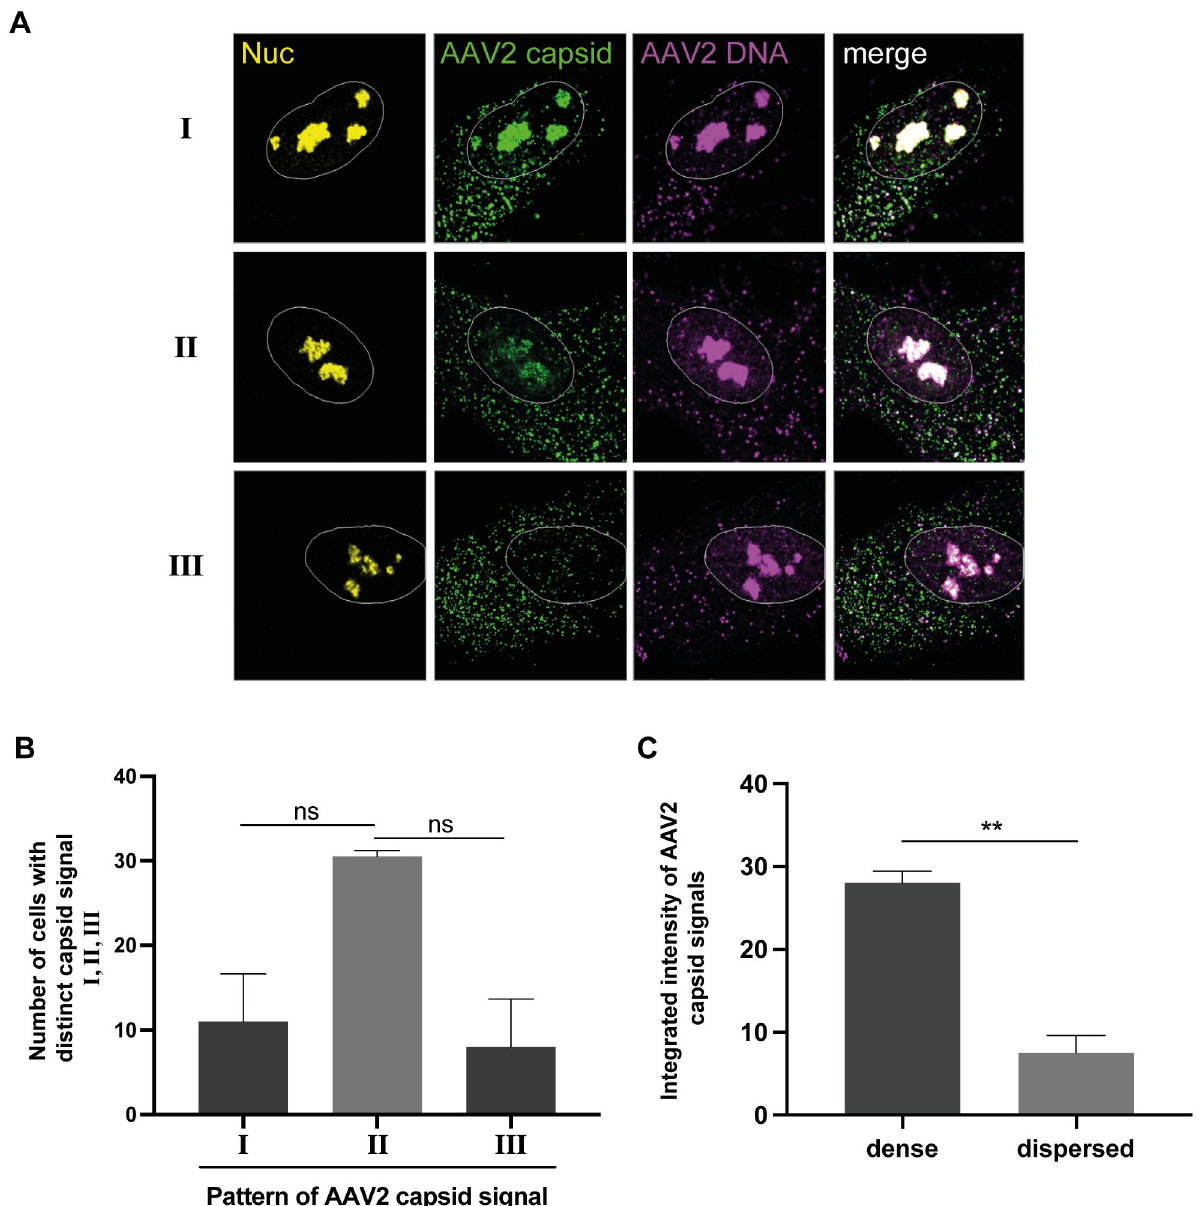
Fig 4. Absence of intact AAV2 capsids in AAV2 genome positive nucleoli points towards complete viral uncoating. NHF cells were infected with wtAAV2 (MOI 20‘000). At 24 hpi, the cells were fixed and processed for multicolor IF analysis combined with FISH and CLSM. Nucleoli (Nuc) were visualized using an antibody against fibrillarin (yellow). Intact capsids were stained using an antibody that detects a conformational capsid epitope (green). AAV2 DNA (magenta) was detected with an Alexa Fluor (AF) 647 labeled, amine-modified DNA probe that binds to the AAV2 genome. Nuclei were counterstained with DAPI and illustrated as white lines. (A) Distinct pattern (I—III) of AAV2 capsid signal in cells with AAV2 genome positive nucleoli. (B) Quantification of 50 individual cells with distinct AAV2 capsid signal. (C) Image-based quantification of the integrated intensity of AAV2 capsid signals in dense or dispersed nucleoli of 70 individual cells. p-values were calculated using an unpaired Student‘s t-test ( � —p � 0.05, �� —p � 0.01, ��� —p � 0.001, ���� —p � 0.0001).